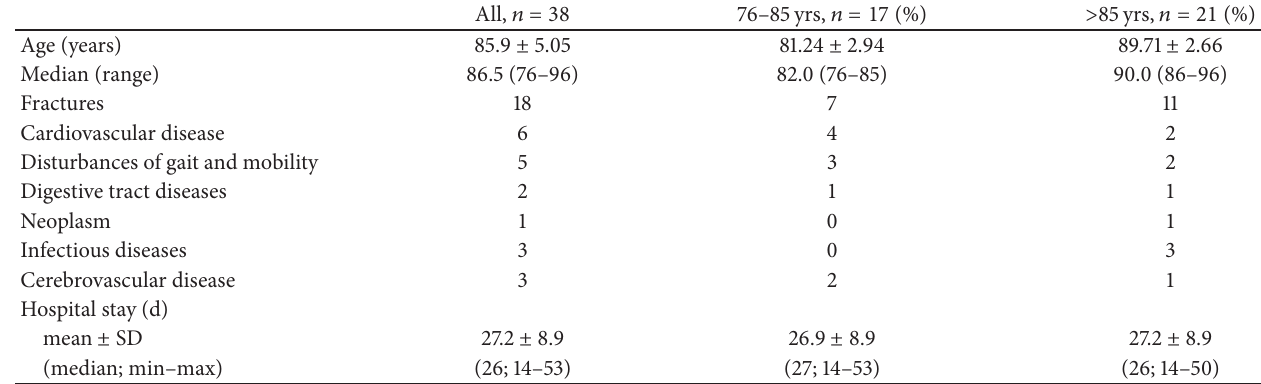
Table 1: Patient characteristics: main reason for hospitalisation and length of stay.